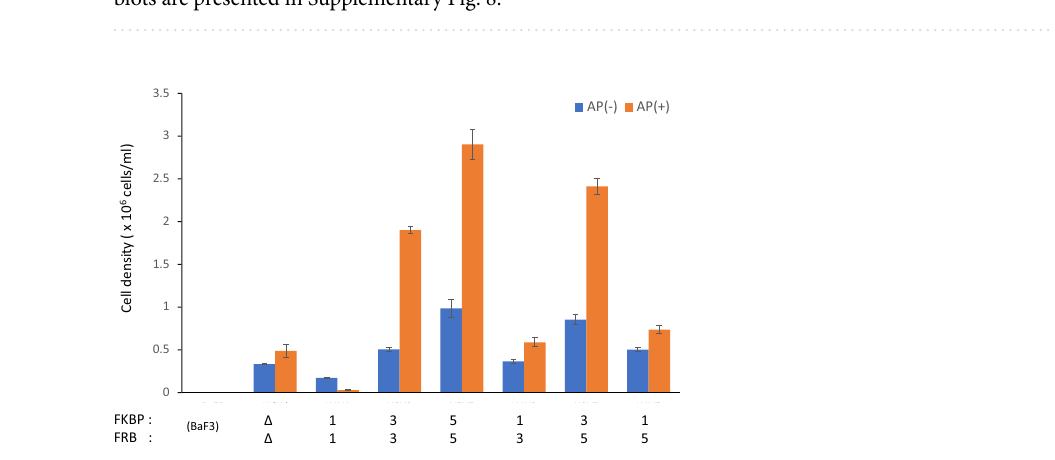
Figure 5. Activation of target signaling molecules using heterodimeric designer receptor. The target signaling molecule-binding motifs were positioned on Y747 of the engineered c-KIT. STAT1-, STAT3-, and STAT5- binding motifs (1, 3, and 5, respectively) were used as the binding motifs. The chimera devoid of tyrosine motifs (Δ) was used as a negative control. In western blotting, parental Ba/F3 and the transduced cells were unstimulated (−) or stimulated with 50 nM AP21967 (+). Phospho-STAT1, whole STAT1, phospho-STAT3, whole STAT3, phospho-STAT5, whole STAT5, myc tag (both FKBP and FRB chimeras; upper and lower bands, respectively), and GAPDH (loading control) were detected using corresponding primary antibodies. Full-length blots are presented in Supplementary Fig. 8.